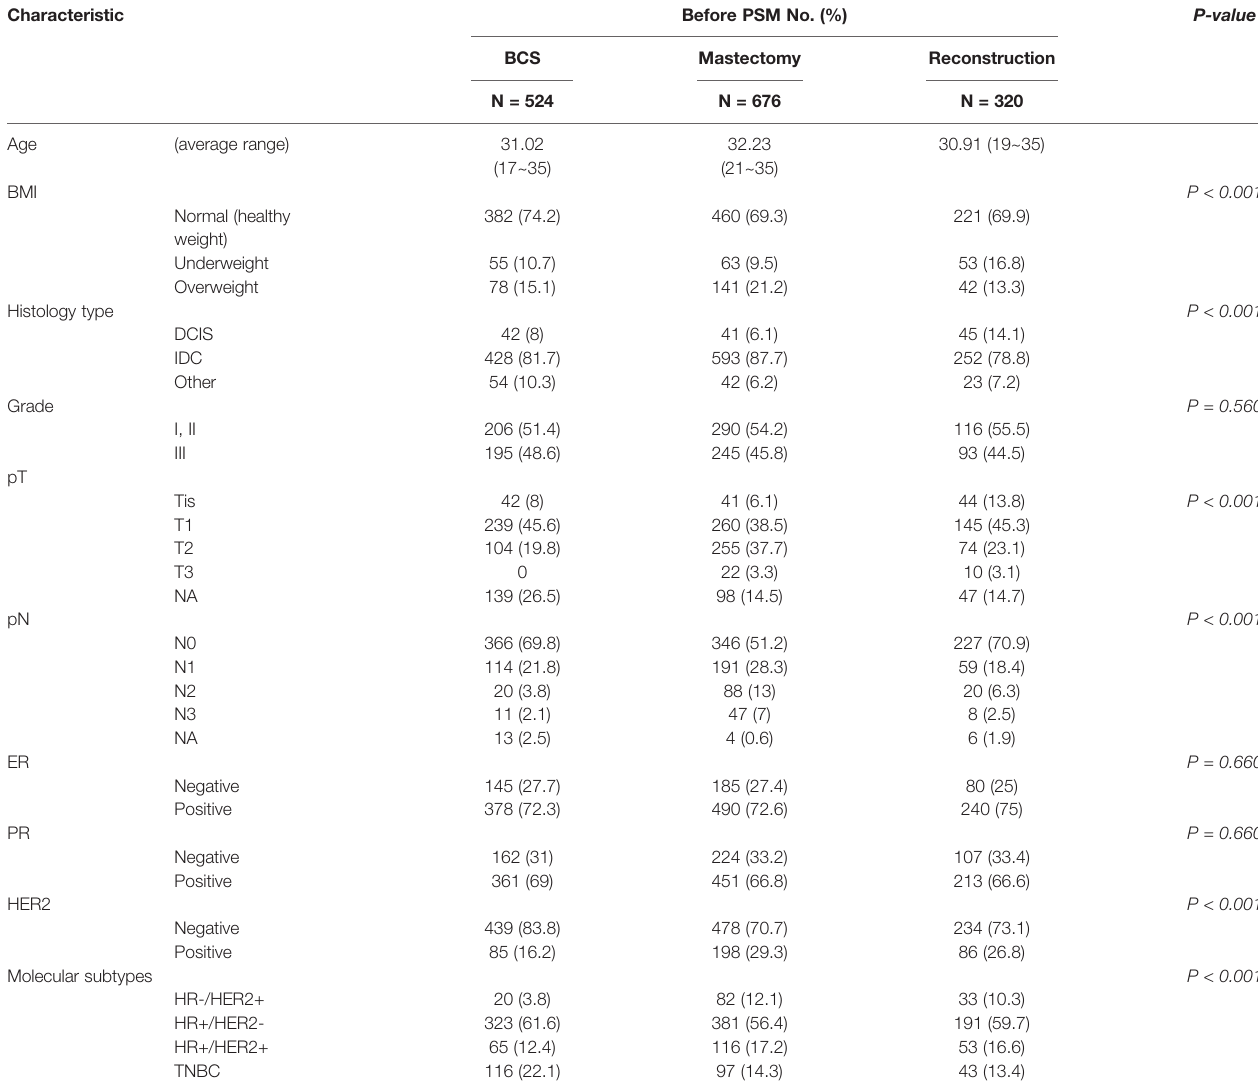
TABLE 1 | Baseline characteristics of young breast cancer patients with different surgical methods before propensity score matching. Characteristic Before PSM No.